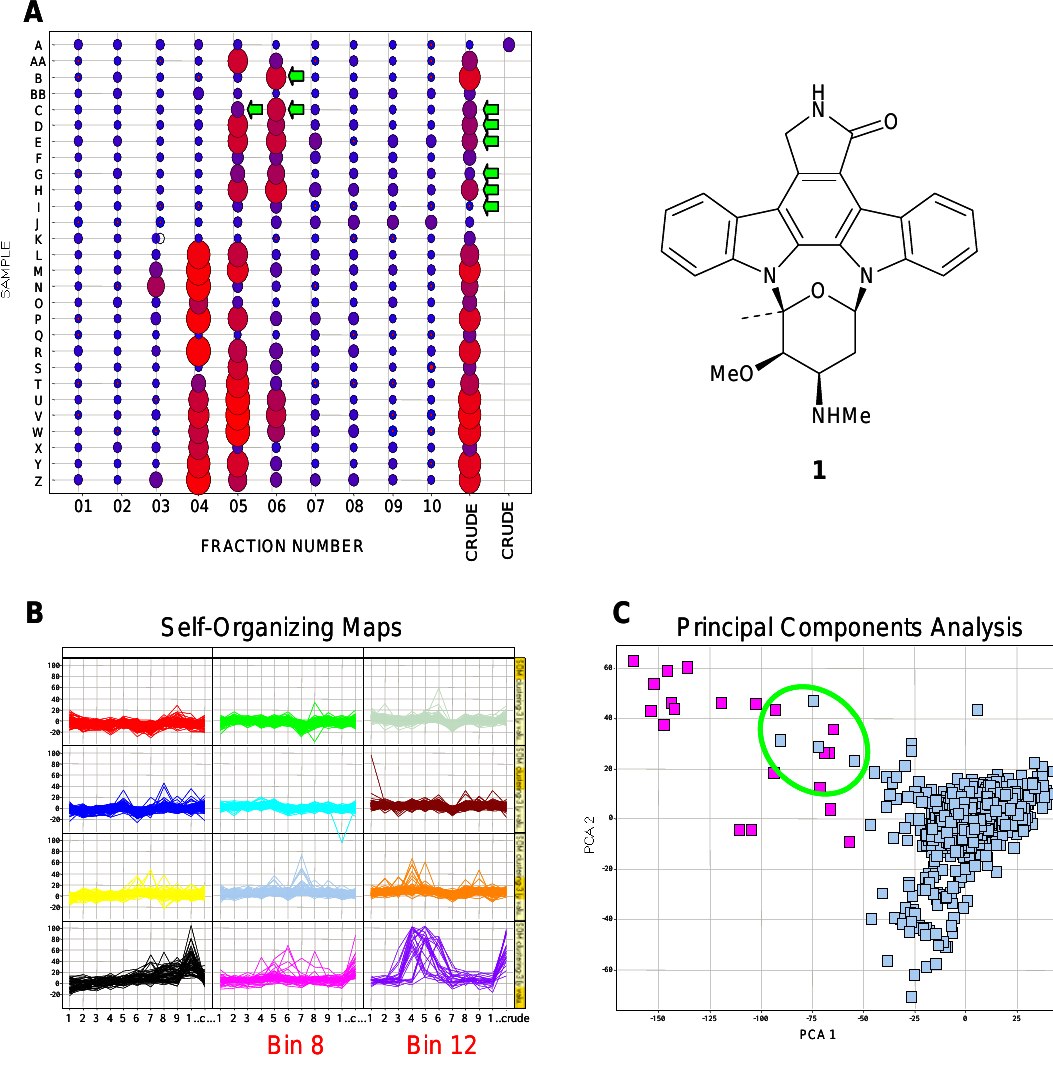
Figure 7. Examples of pattern recognition for actinomycete cultures tested in a kinase screen. A) Activity profiles for twenty-eight active actinomycete cultures. Color and size of the circle correlate with activity. Green arrows indicate samples known to contain staurosporine. B) Self-organizing map of the activity profiles for 1436 actinomycete cultures in a kinase screen. C) Principal components analysis of the activity profiles for 1436 actinomycete cultures. Samples in pink are known to contain